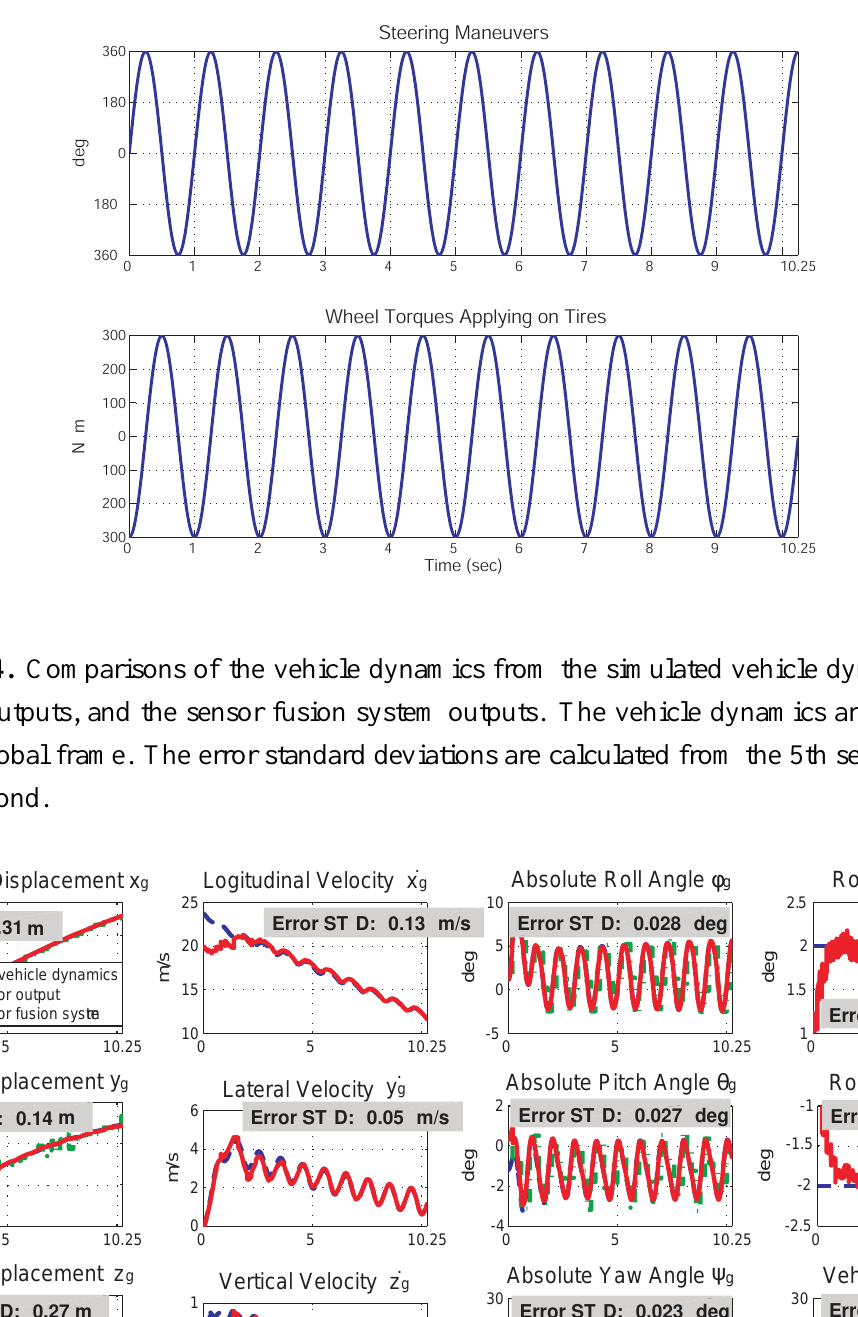
Figure 3. The driving maneuvers for the illustrative simulation. The upper plot is the steering wheel angle and the lower plot is the wheel torques applying on four tires. The frequency is 1 Hz.